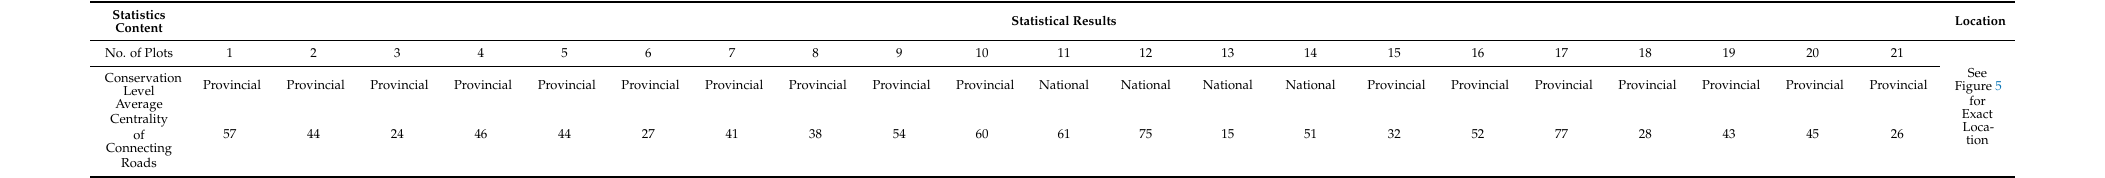
Table 6. Centrality of Construction Land Plots used for Relics and Historic Site Conservation in